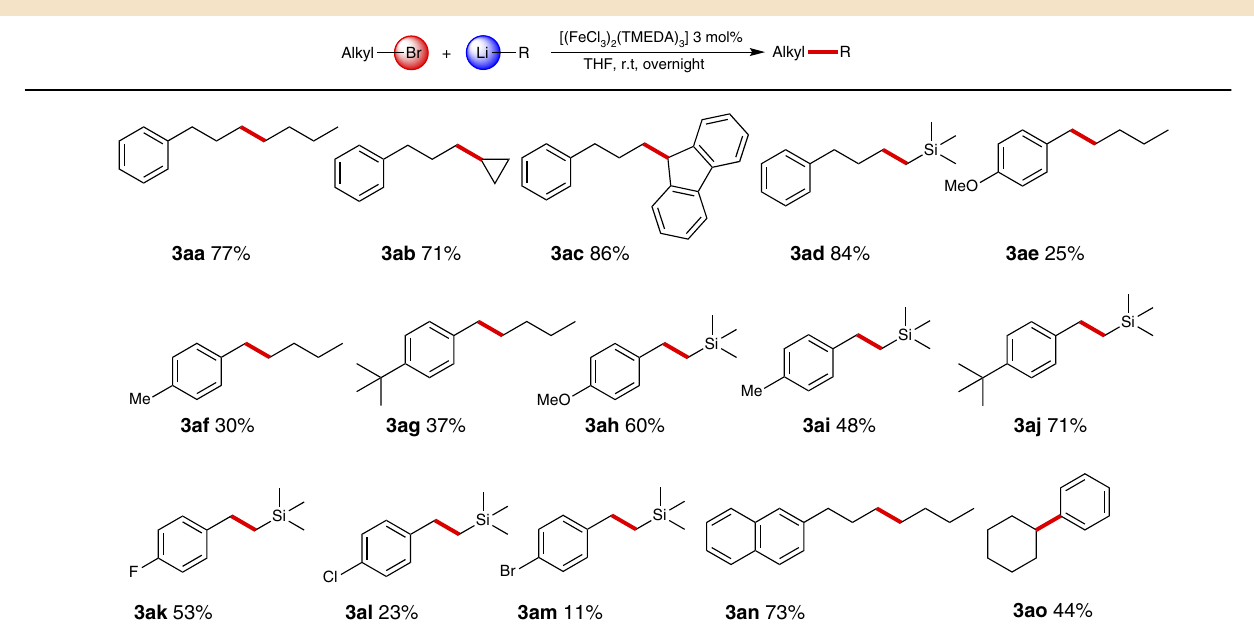
Table 4 | Iron-catalysed cross-coupling of alkyl bromides with organolithium reagents*.